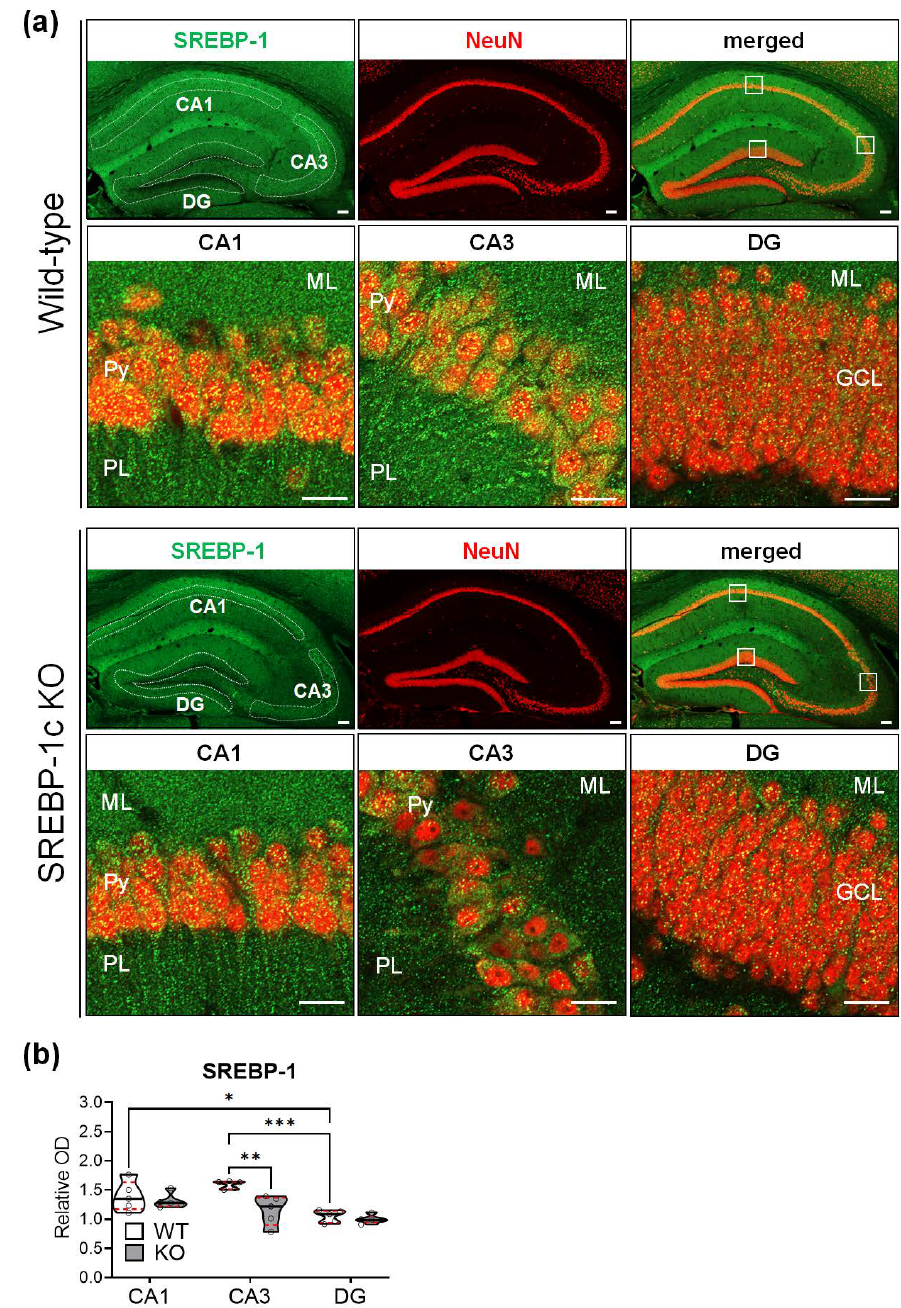
Figure 6. SREBP-1c KO mice show different levels of SREBP-1 protein expressions in each subregion of the hippocampus. Representative immunofluorescence images from each group show expressions of SREBP-1 (green) and NeuN (red)—a neuron-specific marker—in the various hippocampal subregions (CA1, CA3, and DG) ( a ). KO mice showed relatively lesser levels of SREBP-1 expression in all subregions, especially in the CA3 subregion; SREBP-1 was mainly expressed in the pyramidal and granular cell layers of the CA and DG subregions, respectively. Violin plots show the relative intensities of SREBP-1 expression in the pyramidal cell layers (CA1 and CA3) and granular cell layer (DG) in each of the hippocampal subregions (CA1, CA3, and DG) of WT and KO mice ( b ). Upper and lower dashed red lines represent the upper and lower quartiles, respectively, and the median is represented by a solid black line within a violin plot. * p < 0.05, ** p < 0.01, *** p < 0.001 vs. WT ( n = 5 animals/group). The scale bars represent 100 and 20 µ m in the hippocampal and subregion images, respectively. CA, cornu ammonis ; DG, dentate gyrus; GCL, granular cell layer; ML, molecular layer; PL, polymorphic cell layer; Py, pyramidal cell layer; SREBP, sterol regulatory element-binding protein; NeuN, neuronal nuclei; WT, wild-type littermate; KO, SREBP-1c KO